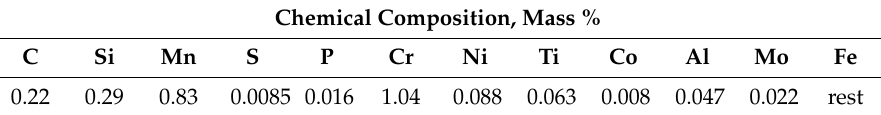
Figure 3. Molding ring. ( a ) Piece used for tests; ( b ) Molding cavity geometry. Table 1. Molding ring chemical composition (optical emission